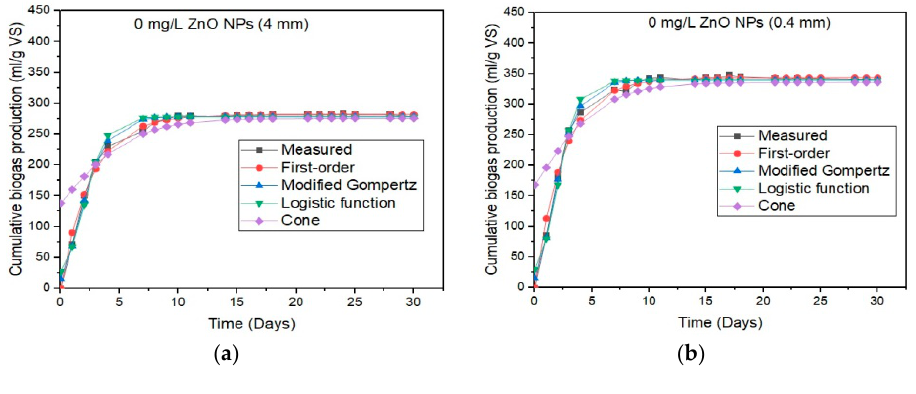
Table 7. Results of the kinetic study using the modified Gompertz and logistic function